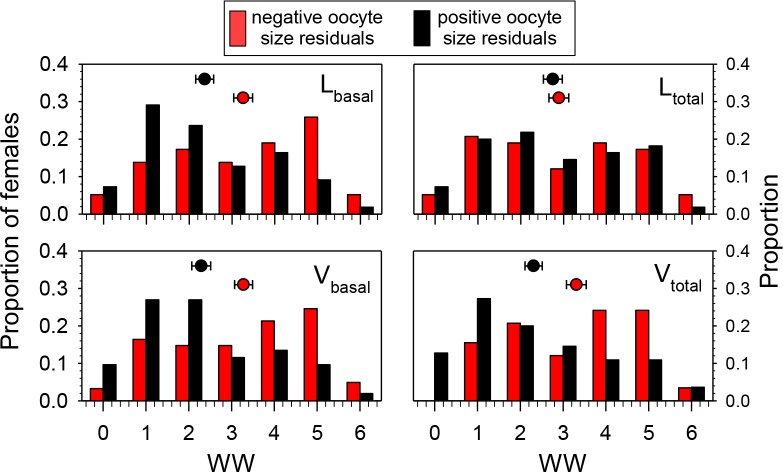
Proportions of females in different wing wear index (WW) categories with either negative or positive residuals for the regressions of Lbasal, Ltotal, Vbasal, and Vtotal (all transformed as the square root of the value + 0.5) on head width (HW).Females with negative residuals had smaller than expected oocyte sizes based on the HW-oocyte size linear regression equation. The regression equations for oocyte variable (square-root transformed) on HW were: (1) Lbasal = 0.329 + (0.341)(HW); F = 81.6, df = 1, 111, P < 0.001, (2) Ltotal = 0.0981 + (0.615)(HW); F = 48.1, df = 1, 111, P < 0.001; (3) Vbasal = 0.0422 + (0.279)(HW); F = 56.4, df = 1, 111, P < 0.001, and (4) Vtotal = − 0.0167 + (0.374)(HW); F = 56.4, df = 1, 111, P < 0.001. Mean ± SE WW values are superimposed above the bars (sample sizes for means range from 52 to 61).